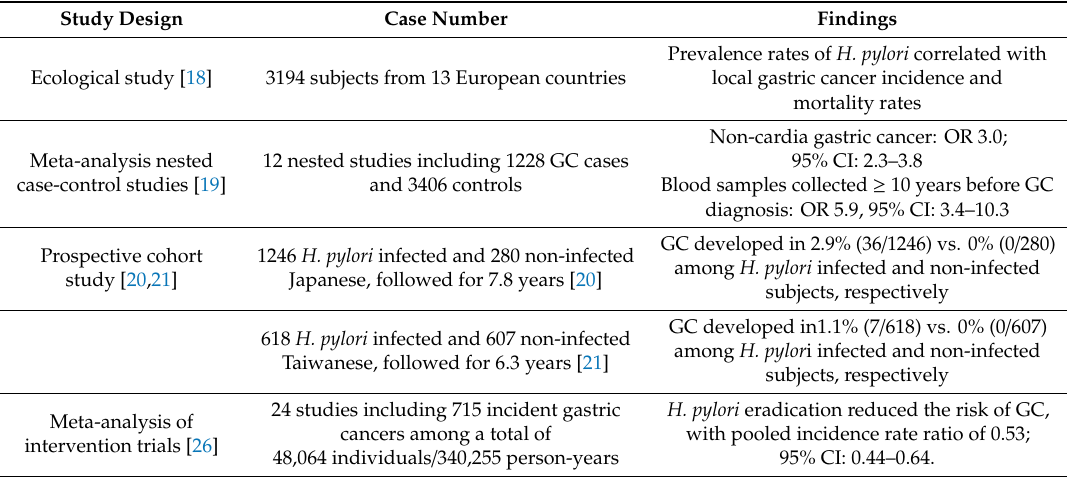
Table 1. H. pylori and gastric cancer risk in